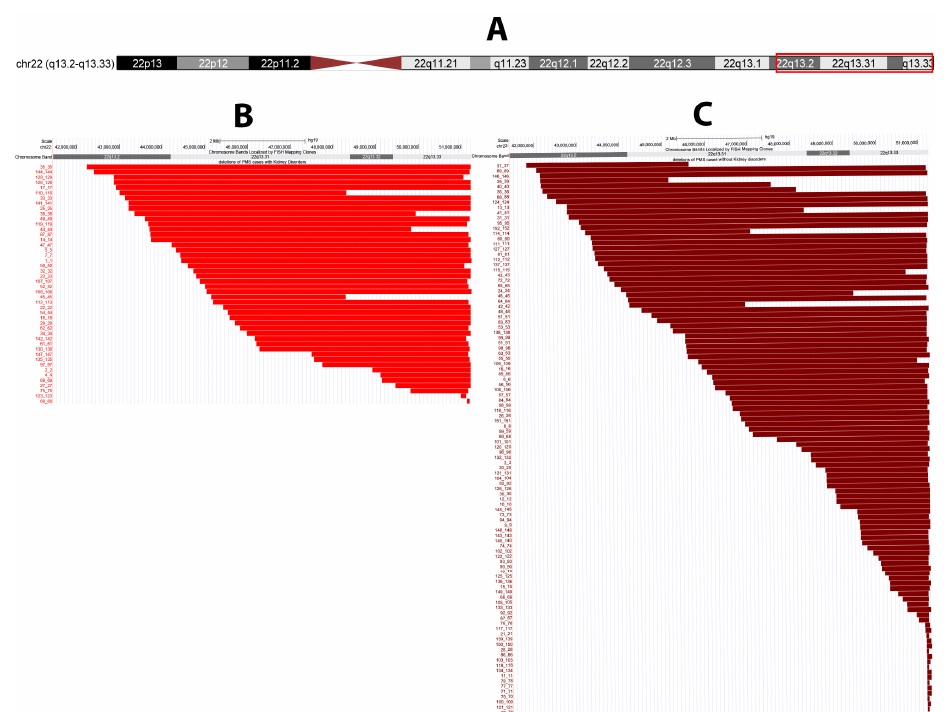
Figure 1. Deletions of people with Phelan-McDermid syndrome. Panel A depicts the chromosome 22q13 region of interest. Panel B presented deletions for individuals with PMS with reported kidney disorders and Panel C depicts deletions for individuals with PMS without reported kidney disorders on the right. Red bars show deleted regions. Figure created from UCSC Genome Browser [37,50]. There are more cases with PMS- SHANK3 -unrelated in the group with kidney disorders. Genes 2022 , 13 , x FOR PEER REVIEW